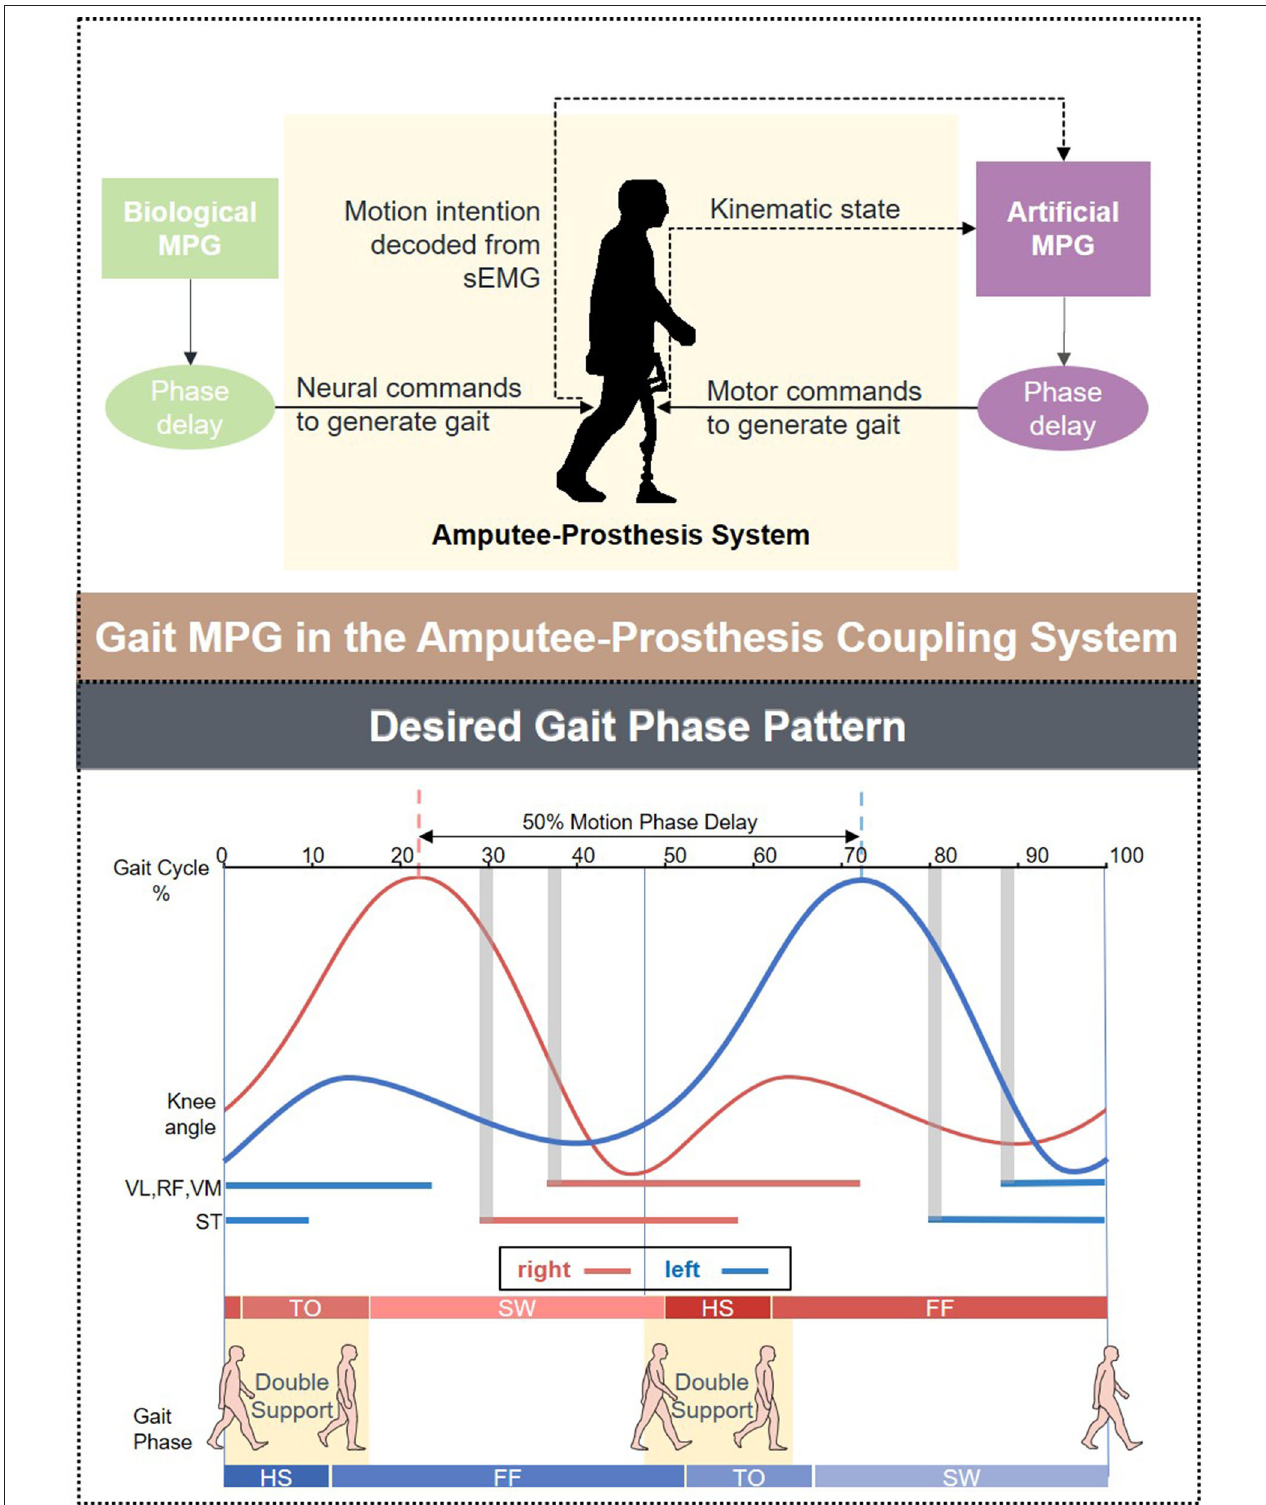
FIGURE 2 | An illustration explains how the coupled movement pattern generator (MPG) architecture produces the desired gait pattern. The schema above shows the information flow between the prosthetic leg and the healthy leg, while a diagram below presents the bilateral knee angle curves and relevant muscles’ onset patterns in one gait cycle. The interval between the dotted lines represents bilateral phase delay. The width of the gray rectangle stands for electromechanical delay (EMD).